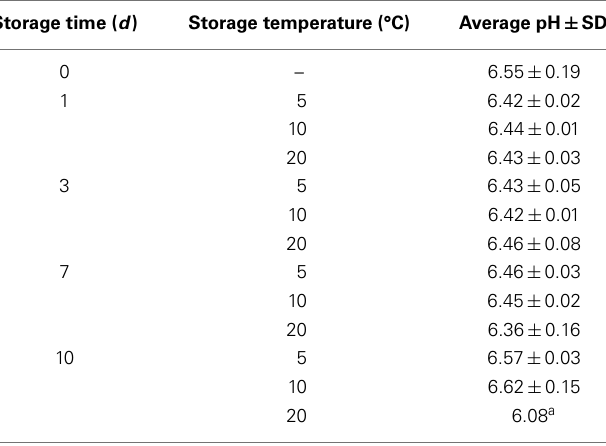
Table 1 | Changes in pH values of oysters during a 10-day storage period .